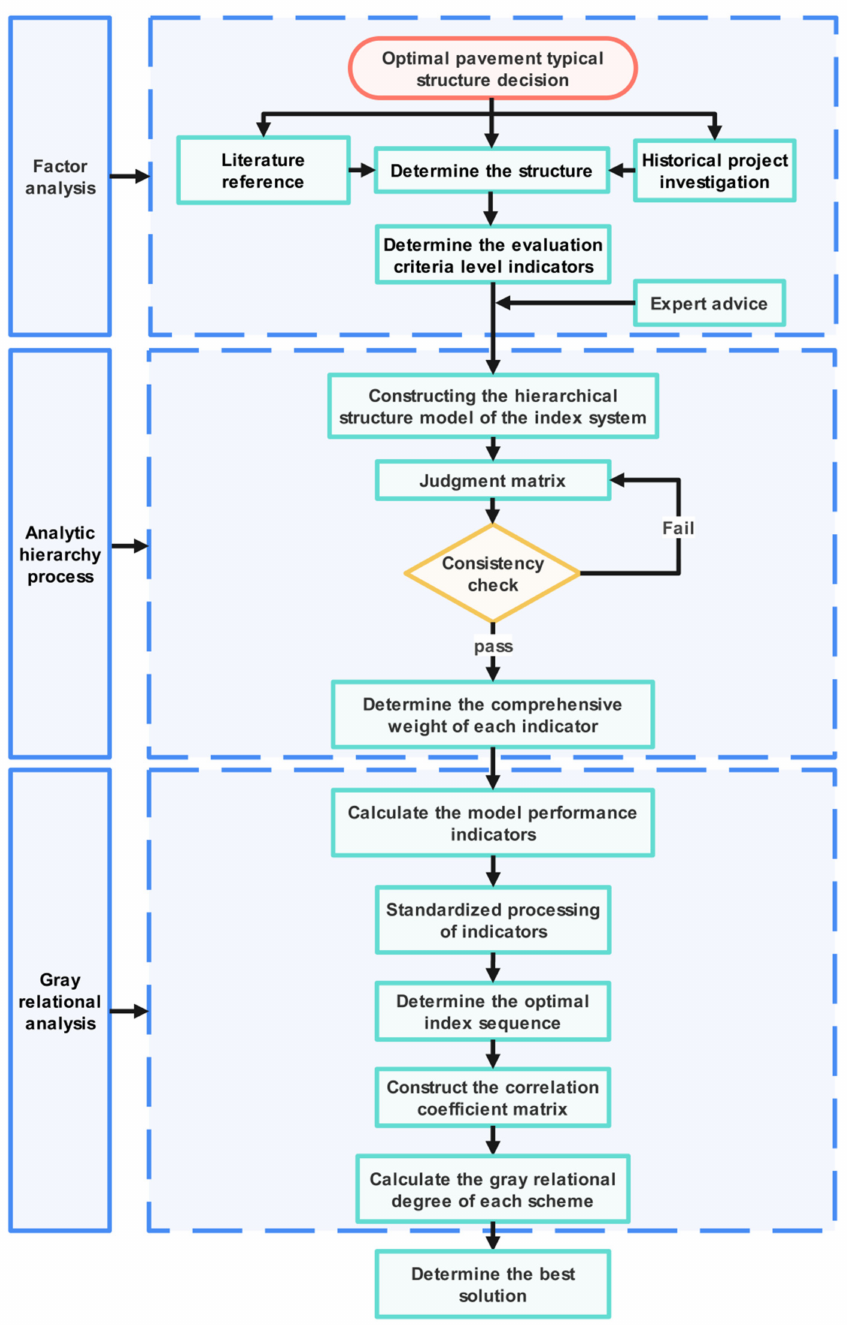
Figure 1. Optimal pavement structure evaluation